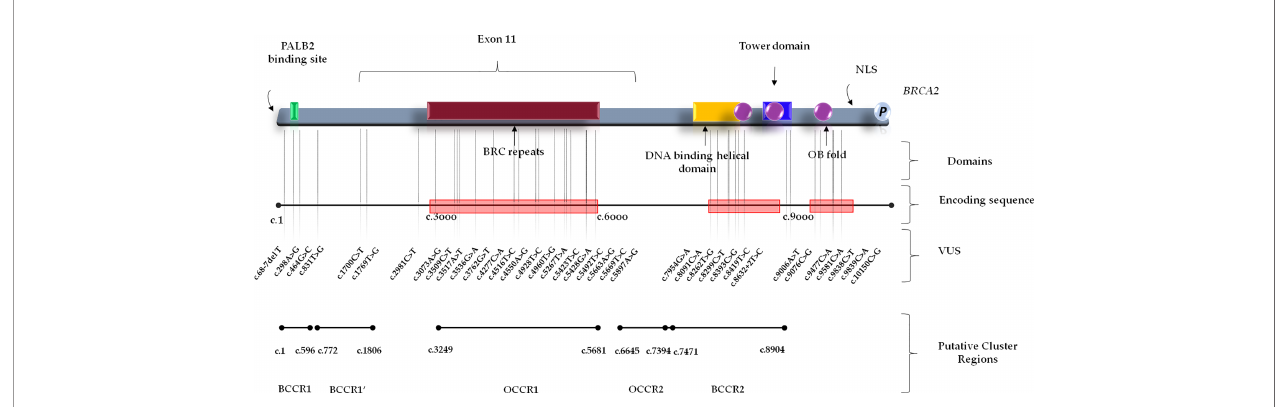
FIGURE 2 | BRCA2 functional domains and gene location of BRCA2 Variants of Uncertain Signi fi cance in BC and/or OC patients. BCCR, breast cancer cluster region; NLS, nuclear localization sequence; OB, oligonucleotide binding; OCCR, Ovarian Cancer Cluster Region; VUS, Variant of Uncertain Signi